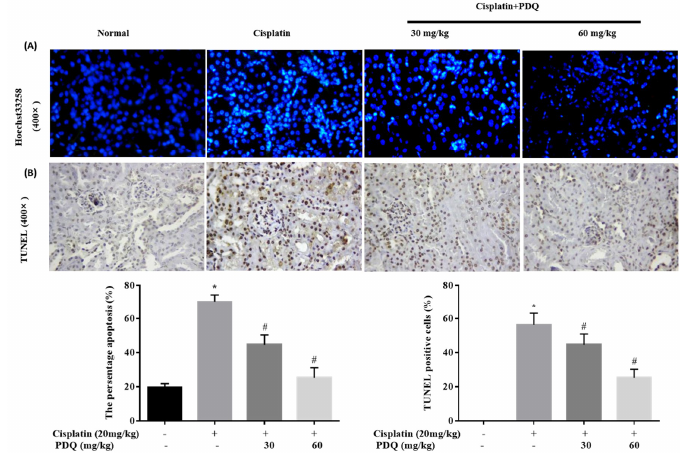
Figure 3. Histological examination of morphological changes in kidney tissues. Renal tissues stained with Hoechst 33258 (400×) ( A ) and TdT-mediated dUTP nick-end labeling (TUNEL) (400×) ( B ); renal tubular cell apoptosis and the presence of TUNEL-positive cells were measured by an image analyzer. n = 8, * p < 0.05 vs. normal group; # p < 0.05 vs. cisplatin